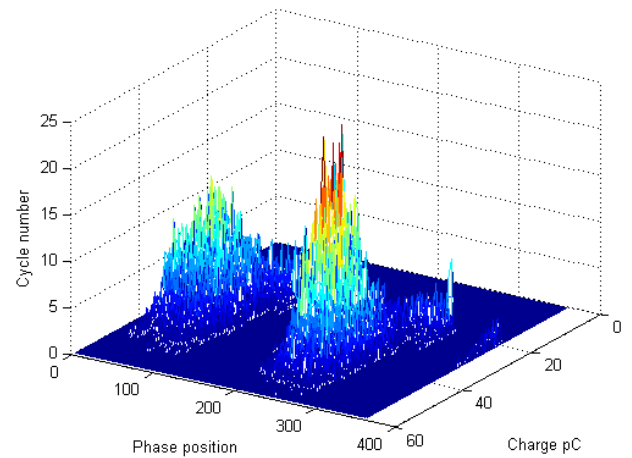
Figure 15. Failure in R-phase cable.